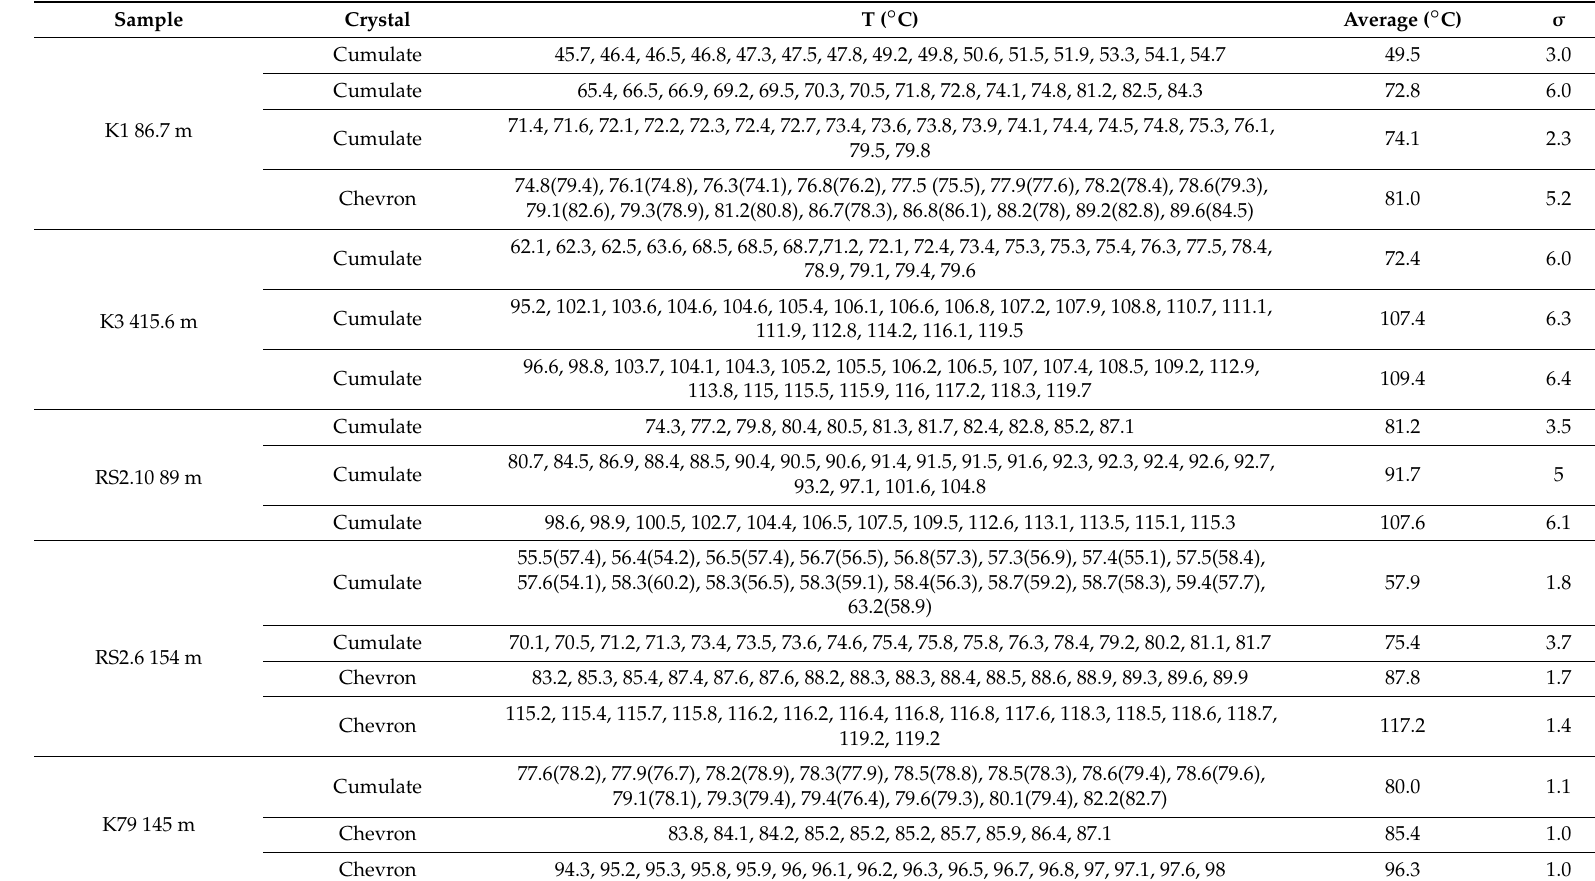
Table 2. Dissolution temperature data from sylvite and carnallite daughter crystals in fluid inclusions, Cretaceous halites from the Maha Sarakham Formation. σ : standard deviation. For some halite crystals, reproduced temperature values are shown in